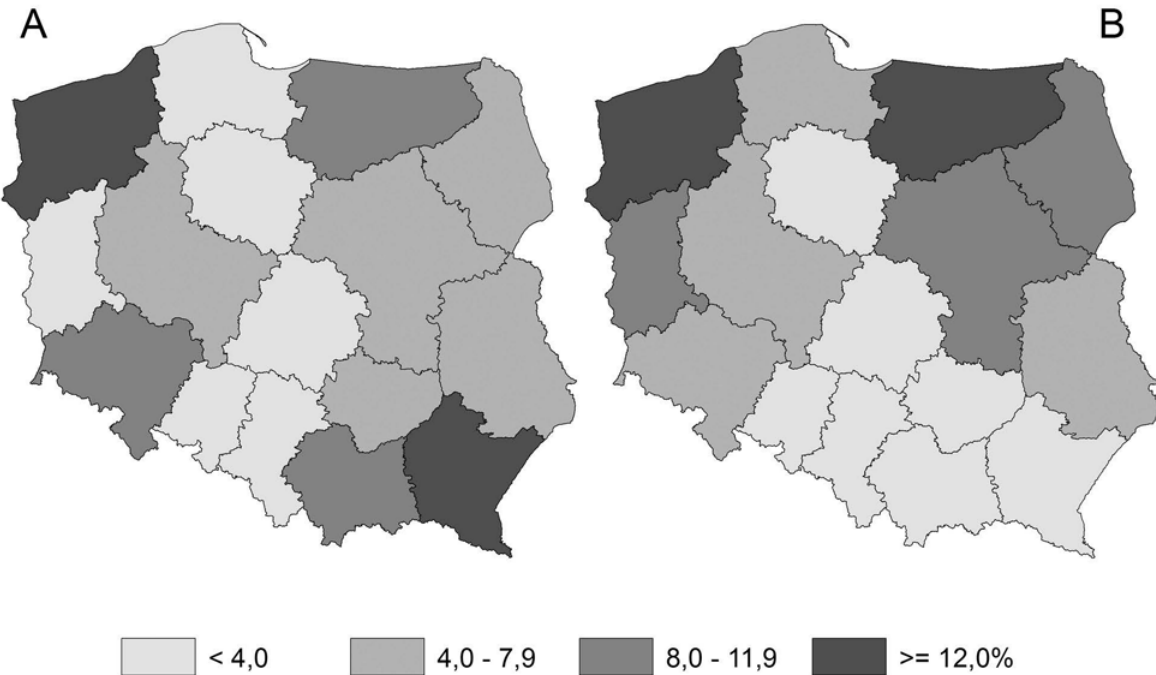
Fig. 7. Proportion of organic farms in Poland by size and voivodeship, 2004 (A) and 2014 (B). Source: own calculations based on data from the Agricultural